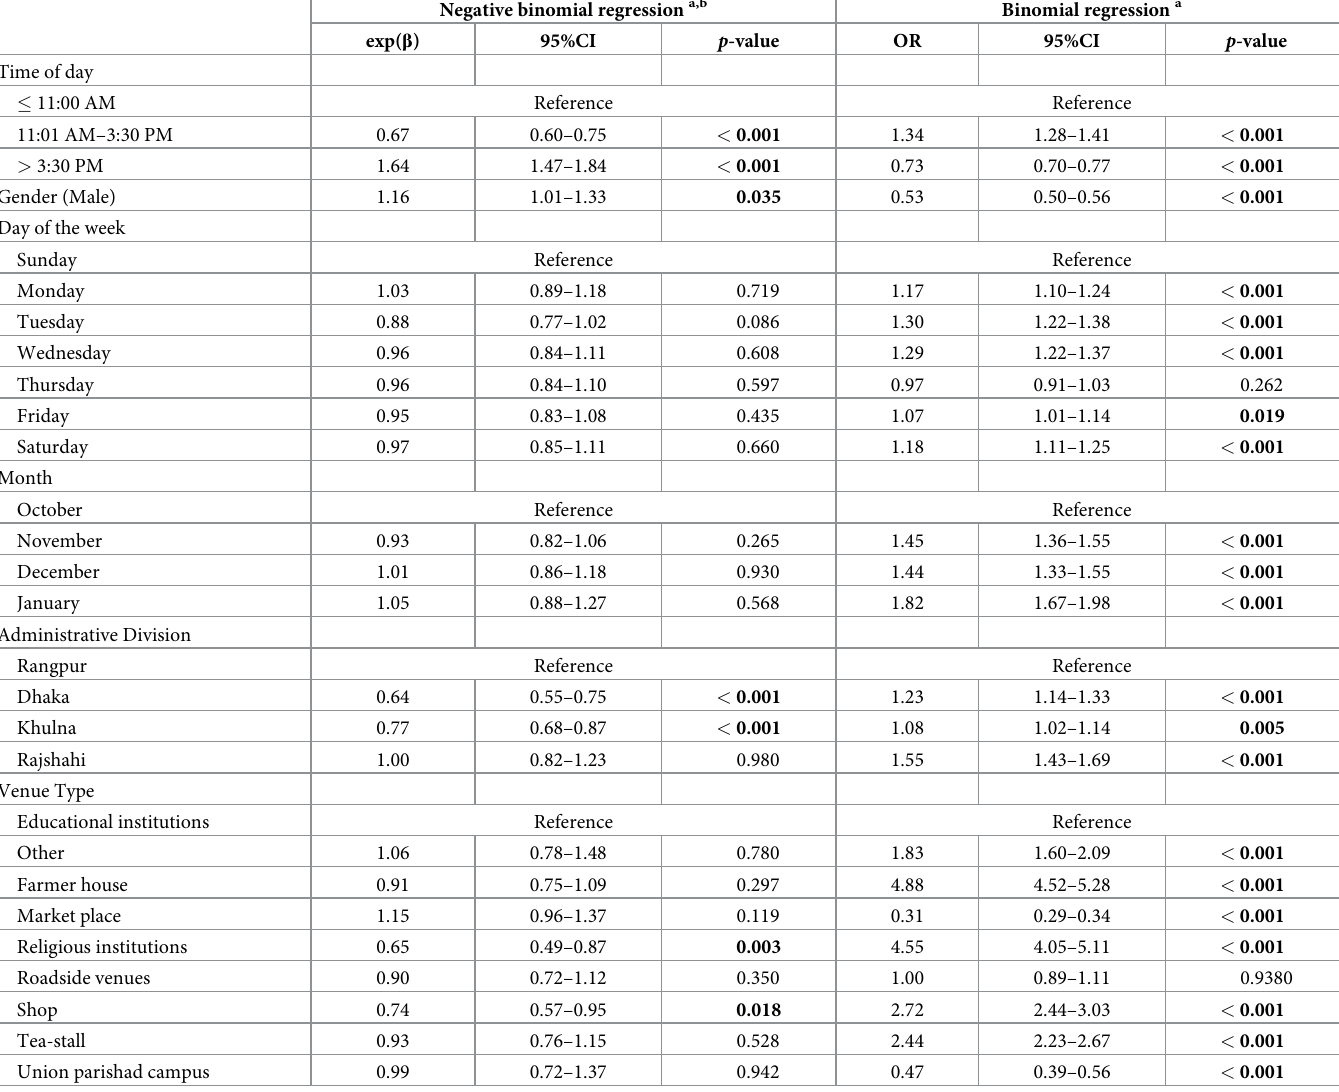
Table 2. Estimates for the negative-binomial and binomial regression models to assess factors associated with the total number of persons and the odds of women attending the